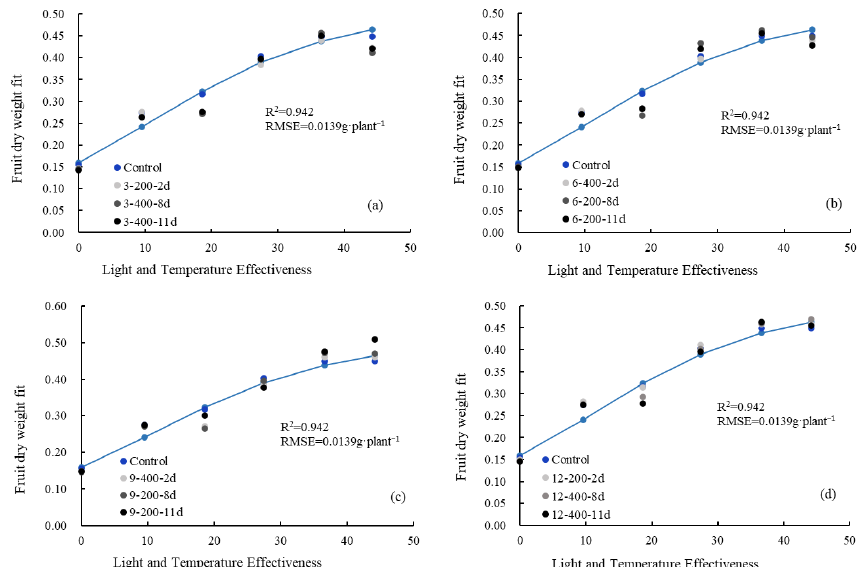
Figure 9. The relationship between the fruit dry weight distribution ratio of cucumbers and LTE under